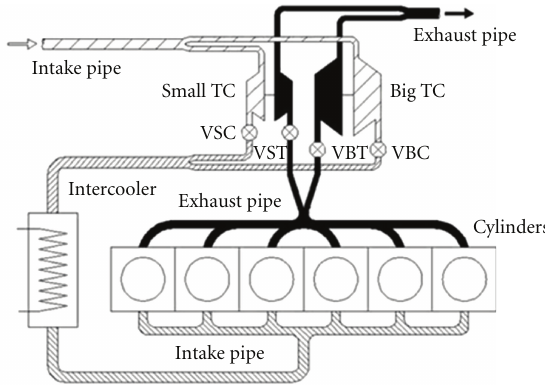
Figure 1: Schematic diagram of the ST system with two unequal- size turbochargers.